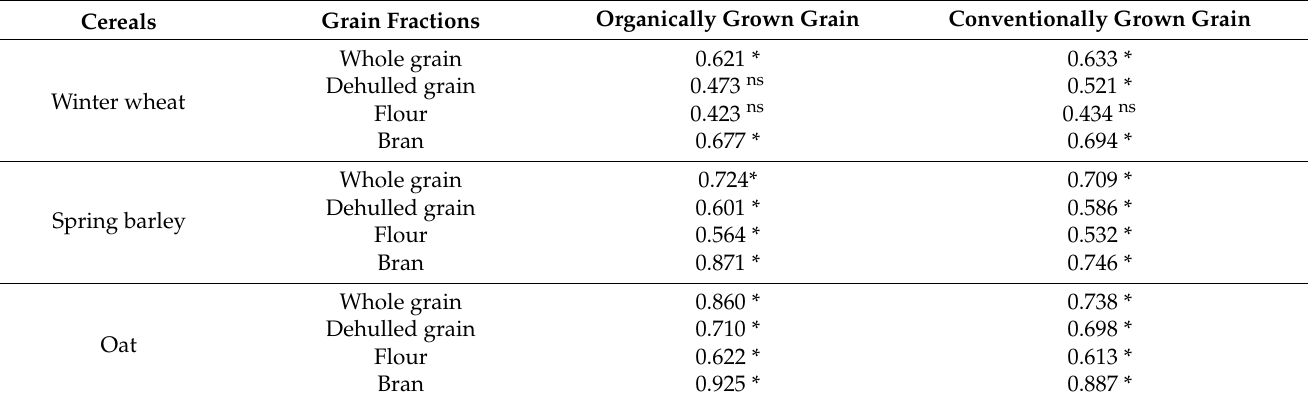
Table 5. Pearson’s correlation coefficients (r) between total phenolic content (TPC) and DPPH • scavenging